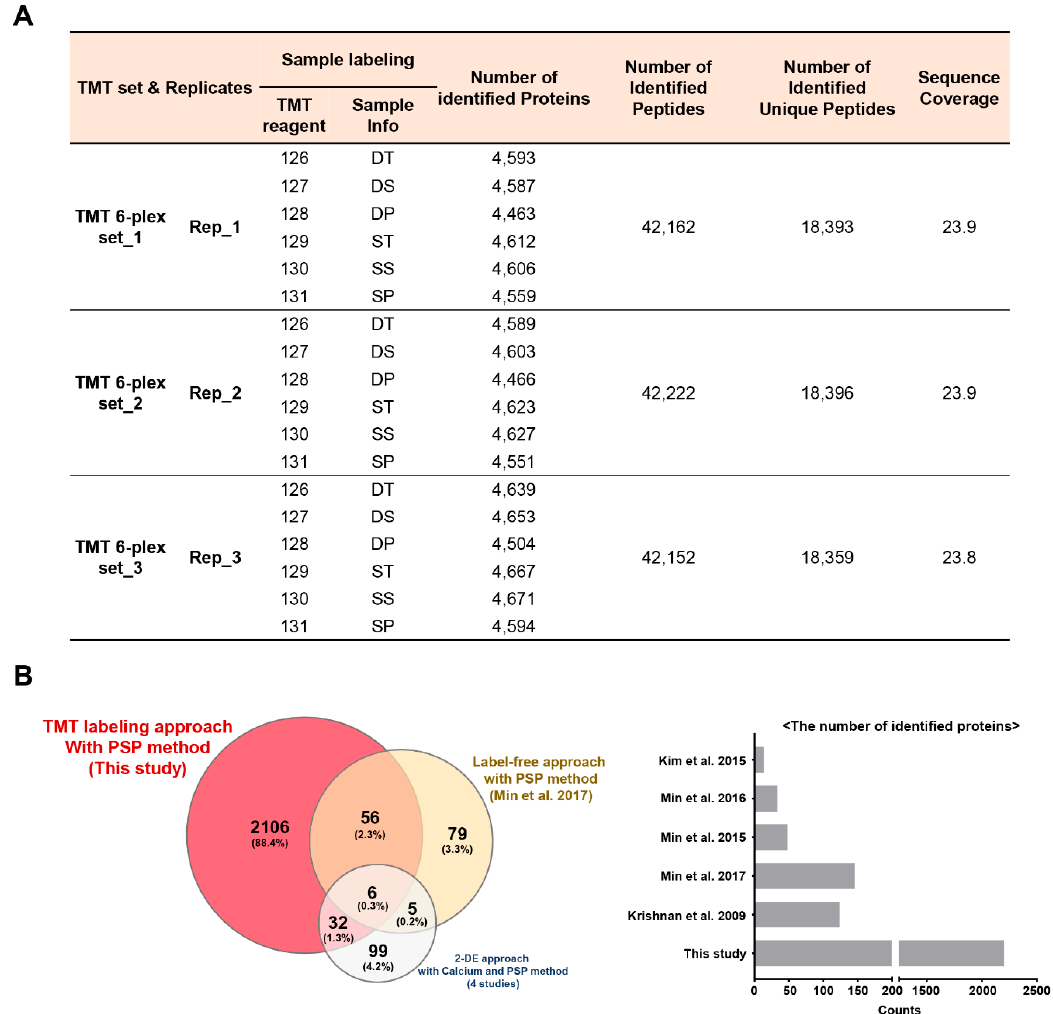
Figure 1. Proteomic analysis of soybean seeds extracted by protamine sulfate precipitation method combined with tandem mass tags (TMT)-based quantitative approach. ( A ) Each sample labeled with different TMT reagents of the 6-plex kit as listed in the table. ( B ) A recently published soybean proteome data analyzed with the pre-fractionation method combined with 2-DGE and label-free was compared to our TMT-based quantitative proteome analysis result.